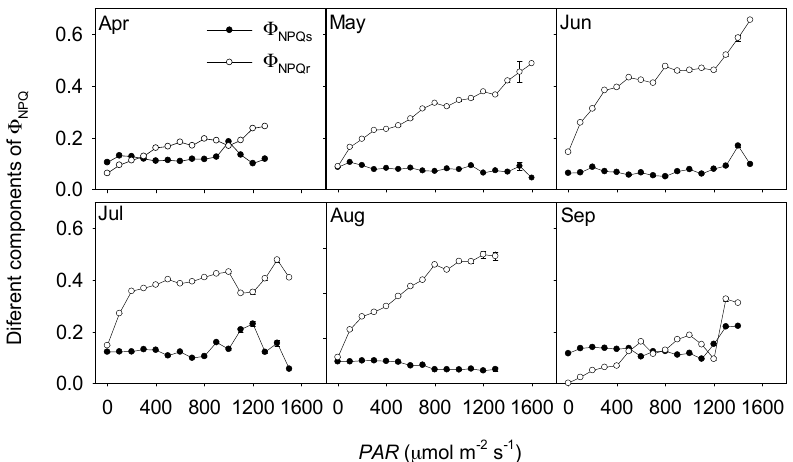
Figure 5. Seasonal variation in sustained and rapidly reversible thermal dissipation (i.e., Φ NPQs and Φ NPQr ) in Salix psammophila as a function of photosynthetically active radiation ( PAR ). Data points of Φ NPQs and Φ NPQr represent bin-averaged values. Here, the bins are set at 100 μ moL·m − 2 ·s − 1 increments of PAR with a minimal sample size of six. The error bars denote standard error.